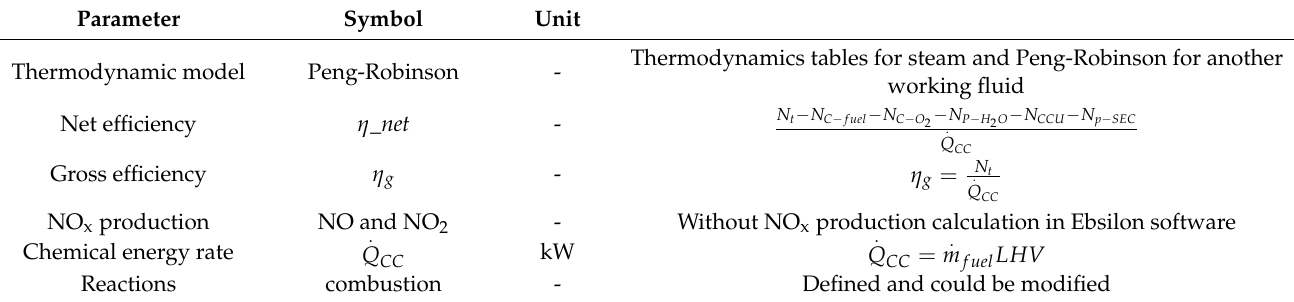
Table 2. Differences and similarities for